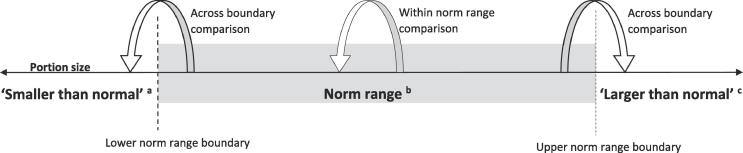
Norm range model. Hypothesised intended consumption: aintended consumption of full portion served and more (compensatory eating), bintended consumption of full portion served and no more, cintended consumption of less than full portion served.